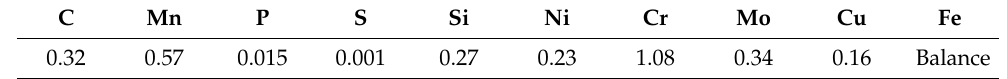
Figure 1. Assembly image of the ingot 12 MT, mold, and hot top (180 ◦ model). Table 1. Initial chemical composition of the Cr ‐ Mo steel ingot, all in wt.% .